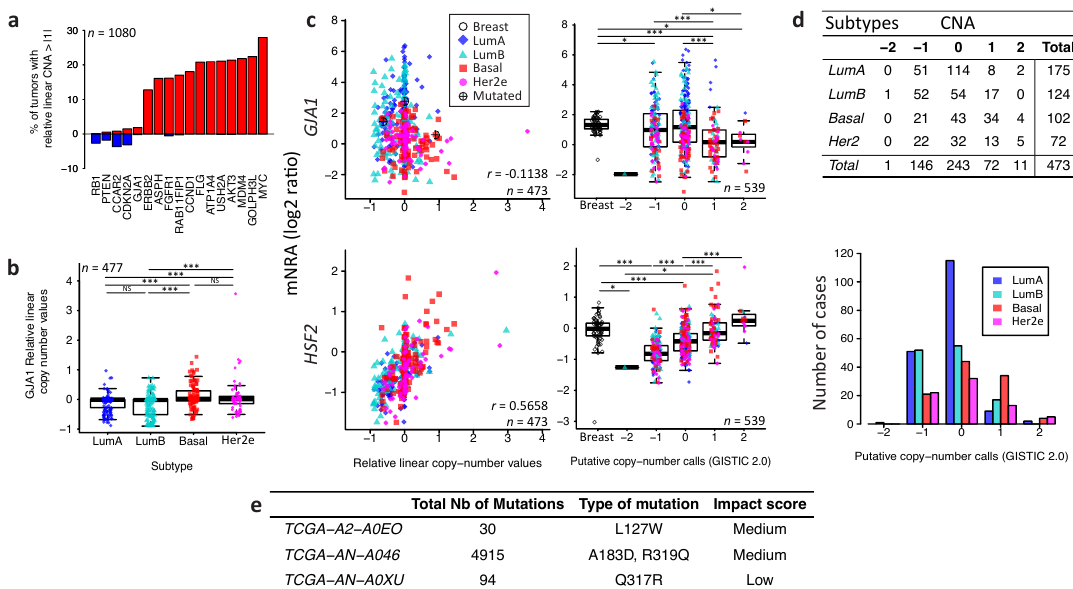
Figure 3. Somatic DNA-level events of GJA1 do not drive expression changes of GJA1 in breast cancer. ( a ) Percentage of tumors with a relative linear copy number >1 (amplification, in red) and < − 1 (hemi- or homozygous deletion, in blue) for GJA1 compared to other genes known to be altered in breast cancer. ( b ) Relative linear copy number value for each breast cancer subtype. ( c ) Somatic copy number alteration and putative copy number calls against mRNA expression for GJA1 and HSF2 . Copy number calls were computed by TCGA using GISTIC 2.0 ( − 2, Homozygous deletion; − 1, Hemizygous deletion; 0, Neutral/no change; 1, Gain; 2, High level amplification). Pearson’s correlation coefficient between relative linear copy number value and mRNA expression is given GJA1 and HSF2 . In the legend, “Breast” indicates adjacent normal breast tissue. ( d ) Contingency table and barplot showing the distribution of copy number alteration (CNA) by subtype. Due to the small number of samples in − 2 and 2 CNA, Fisher’s exact test was applied on − 1, 0 and 1 CNA. ( e ) Total number and GJA1 mutations observed in the 3 cases out of 988 patients. All data from the TCGA dataset. p value: * <0.05; ** <0.01; *** <0.001; NS Not statistically